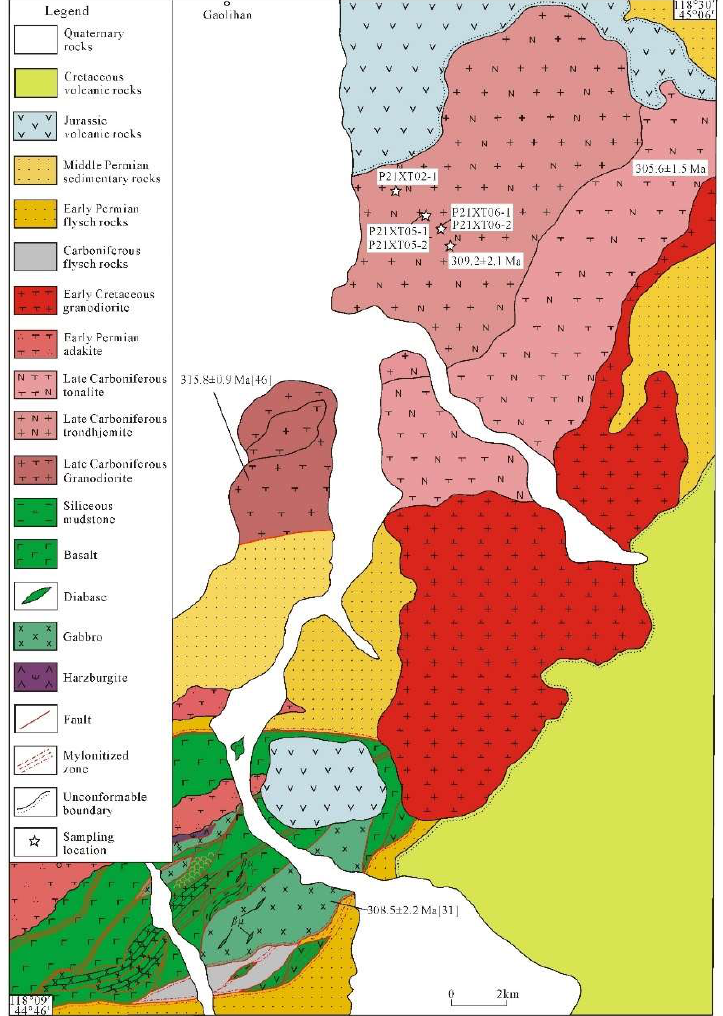
Figure 2. Geological map of the Gaolihan trondhjemite.